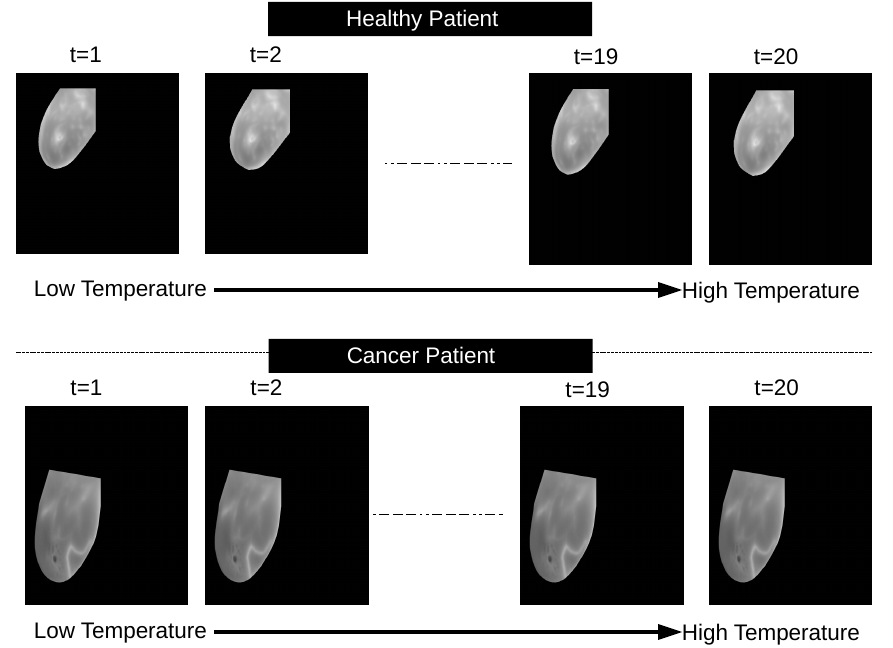
Figure 1. Samples of two dynamic thermogram sequences for two cases, where each sequence comprises 20 infrared images. The infrared images of the left breast acquired at different time steps ( t 1 , t 2 , t 19 , t 20 ) for a healthy case ( top ) and a cancer patient ( bottom